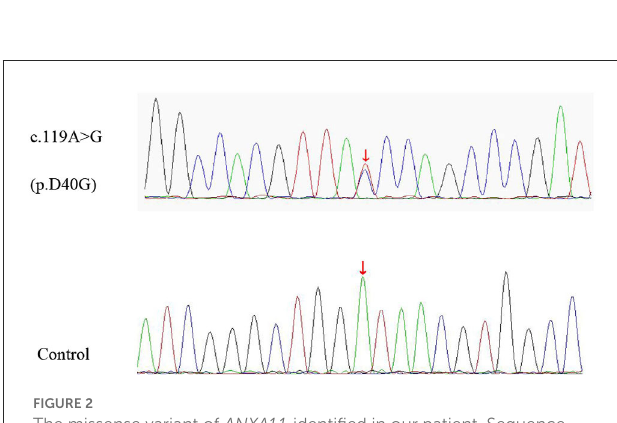
FIGURE2 The missense variant of ANXA11 identified in our patient. Sequence chromatograms of polymerase chain reaction (PCR) show the heterozygous c.119A > G (p.D40G) variant (upper lane) compared with healthy control (lower lane)